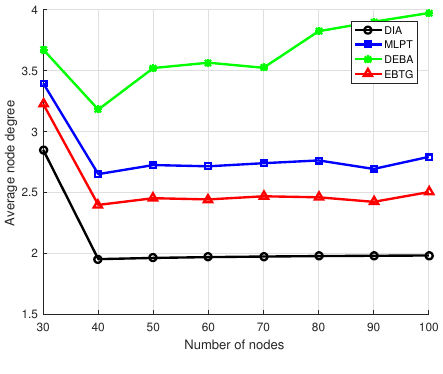
Figure 7. Average node